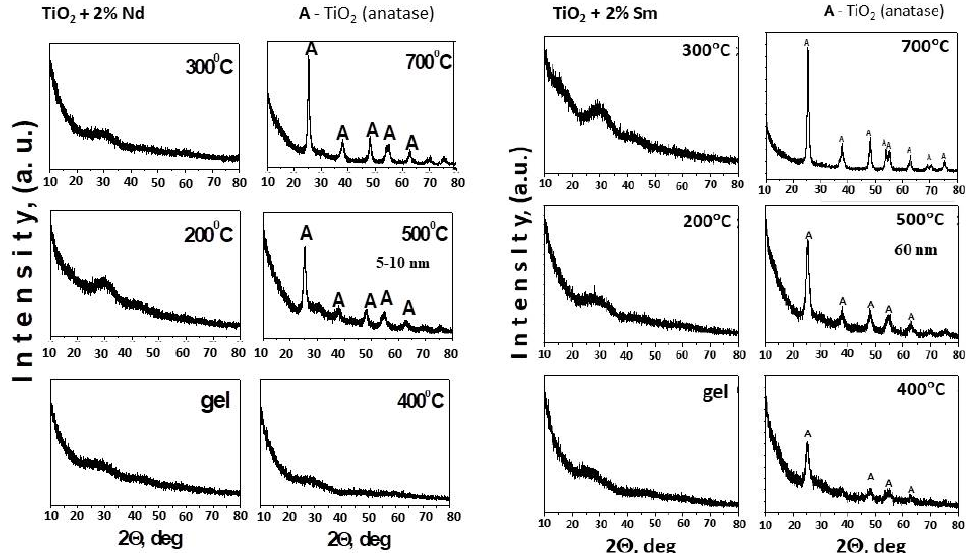
Figure 2. XRD patterns of TiO 2 modified with 2% Nd and 2% Sm heat-treated at different temperatures: (A) TiO 2 -anatase.